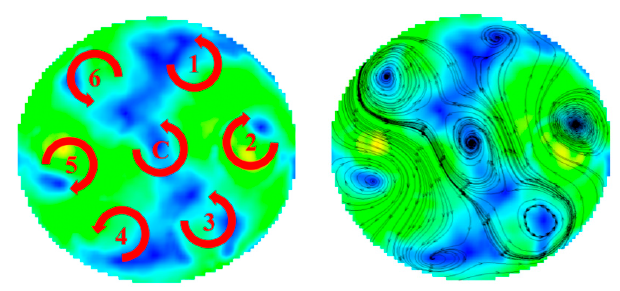
Figure 13. Flow coupling in section H3.